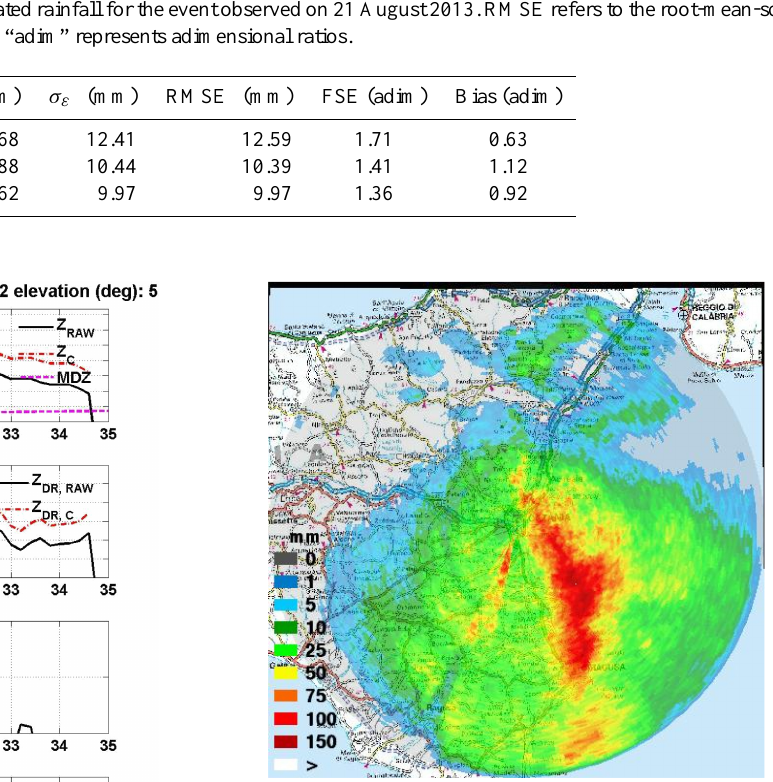
Figure 16. Map of cumulated precipitation as retrieved by the com- bined polarimetric algorithm between 04:00 and 10:00UTC on 21 August